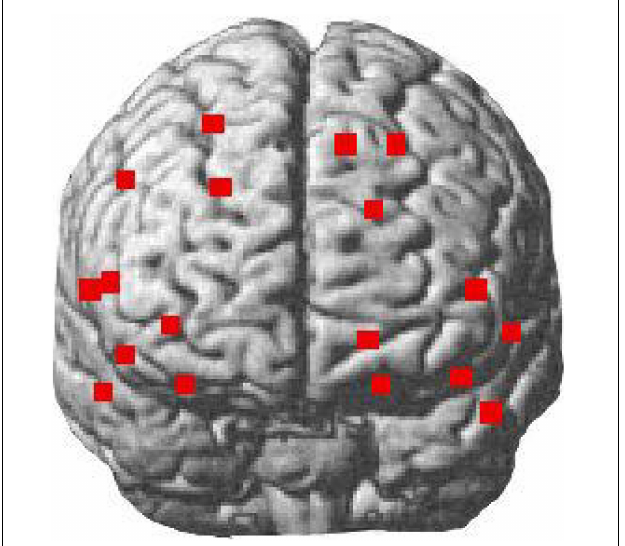
FIGURE 4 | The configuration of the fNIRS channels. The dots on the brain model indicate the location of the arranged